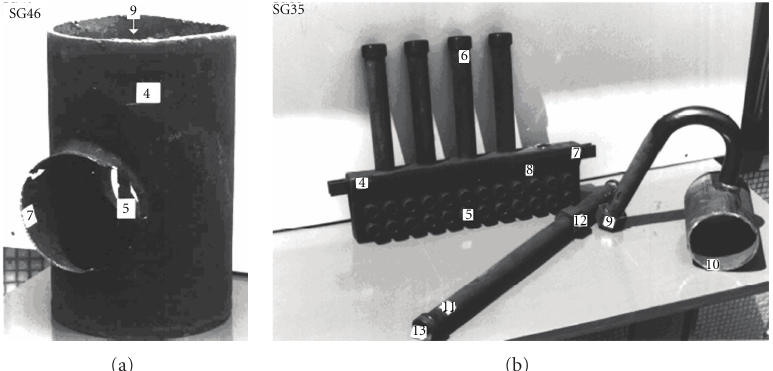
Figure 3: Parts of the SGs 46 (left, feed water dispersion tube) and 35 (right, feed water dispersion box). The places, where samples were scraped from, are marked with the corresponding number (see Table 2) [1, 3, 11, 19, 20]. No. 9 of SG46 can be found inside the tube.